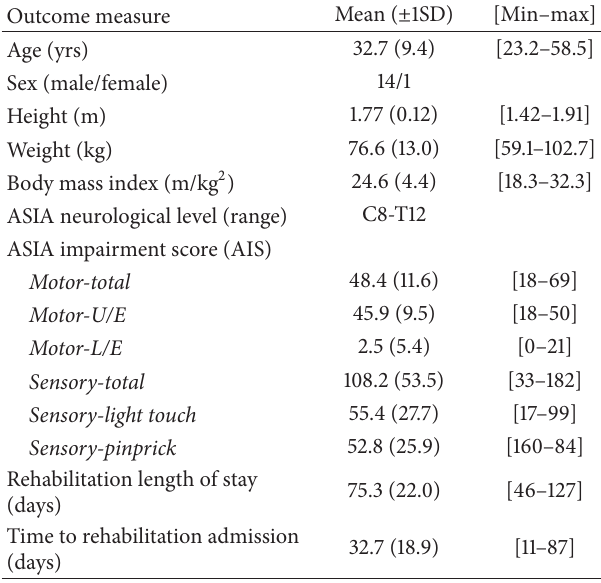
Table 1: Demographic, clinical, and administrative outcome mea- sures describing participants ( 𝑁 = 15